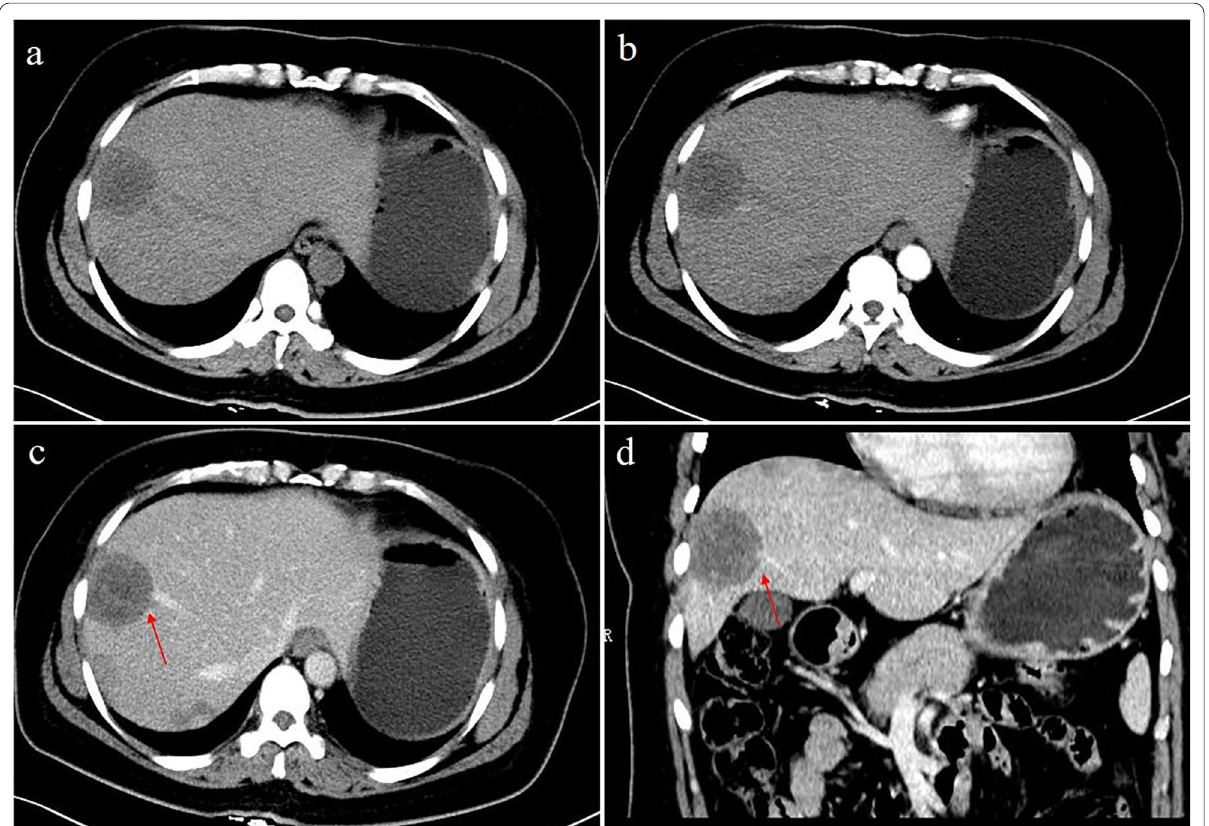
Fig. 3 A 48-year-old female with multifocal nodular type HEH. An axial unenhanced CT image ( a ) shows multiple round-like low-density lesions in the right lobe of the liver. The lesions show slight enhancement in the arterial phase ( b ). Axial and coronal reconstruction of portal phase CT images ( c , d ) show a larger nodule in the right lobe with portal veins entering and terminating in the periphery of the lesion (red arrow). This configuration resembles a typical “lollipop”